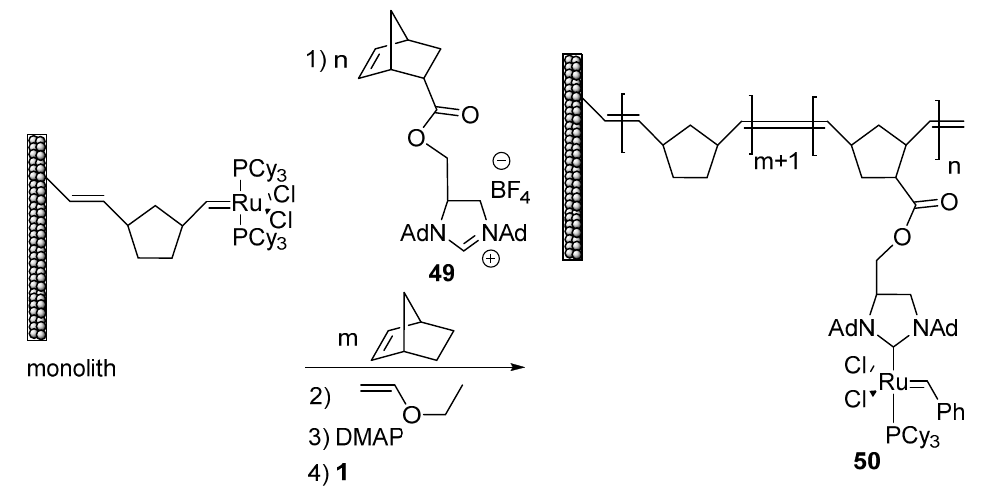
Scheme 2. DVB-PS-Supported Olefin Metathesis Catalysts 6 , 47 , and 48 .